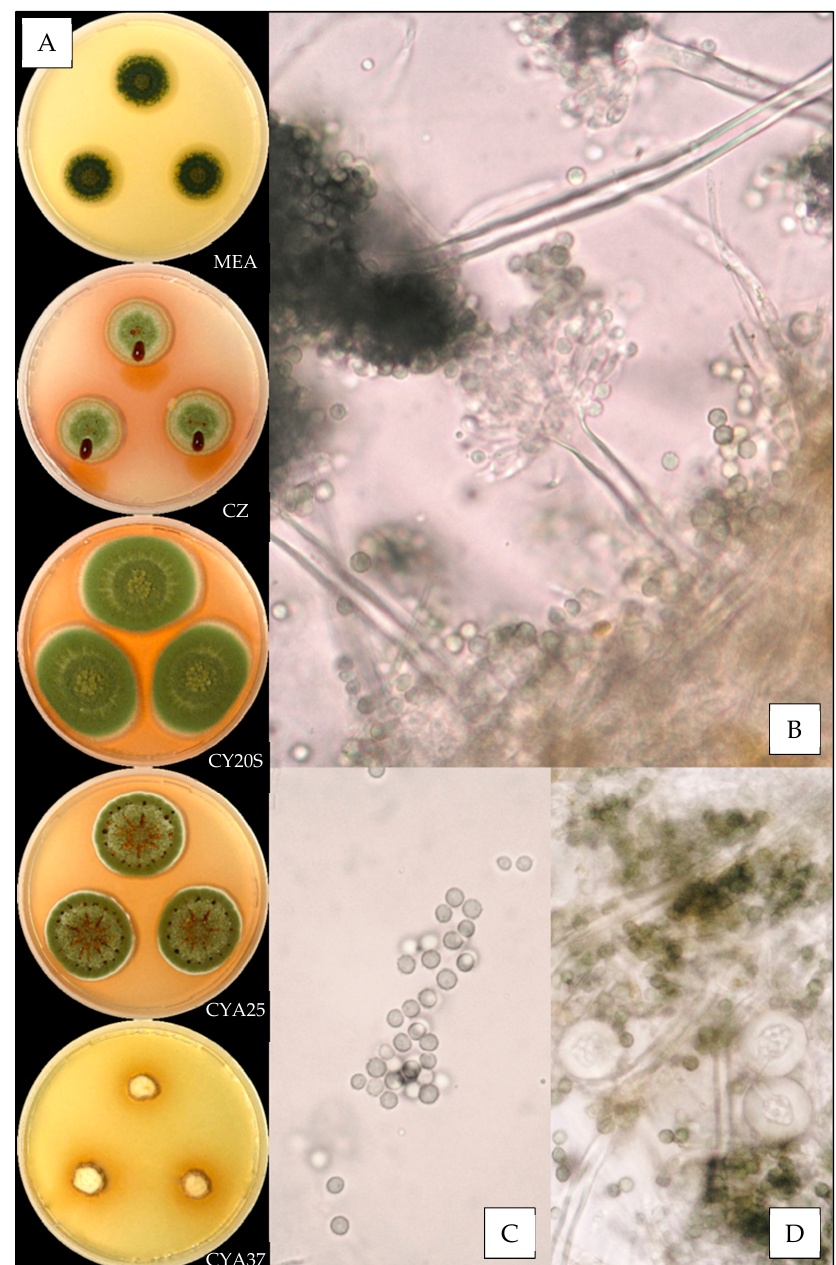
Figure 3. Aspergillus creber : ( A ) from top to bottom, colonies on MEA, CZ, CY20S, CYA25 and CYA37, 14 days. ( B ) Conidial head, ( C ) conidia and ( D ) globose Hülle cells (1000×).